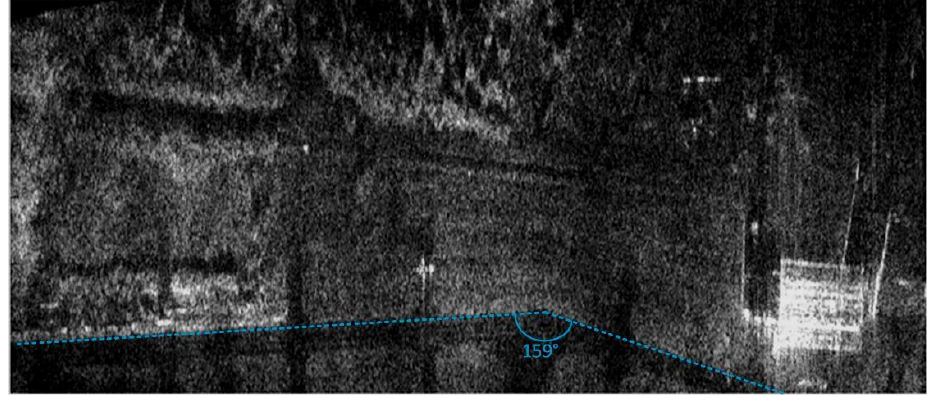
Figure 14. Radar terrain image obtained with the use of MINS data.